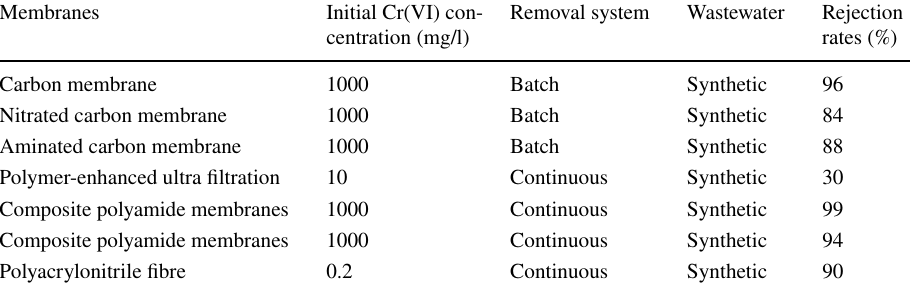
chromium by various membranes